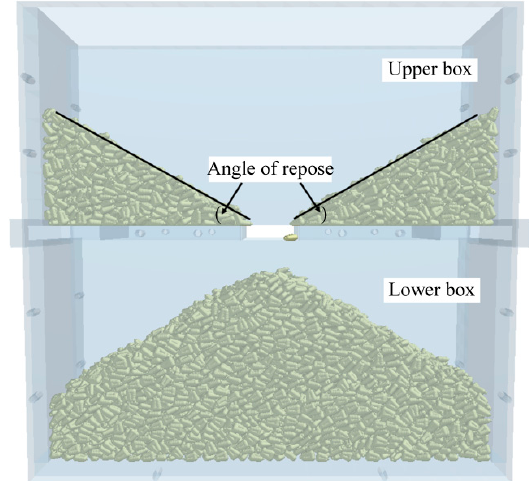
Figure 5. Schematic of the draw-down